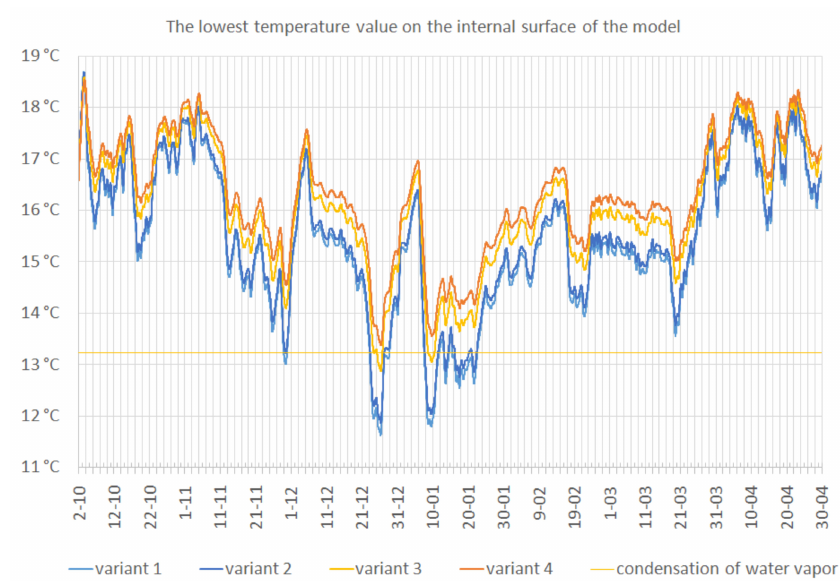
Figure 11. The lowest temperature values on the internal surface of the model for the four analyzed